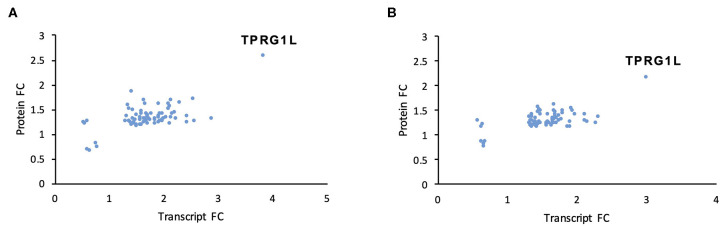
Dysregulation of cellular transcripts and proteins in RNA1.2 mutant-infected cells. HFFF2 cells were infected with WT, ΔRNA1.2 or ΔTATA at MOI = 5 and analyzed at 72 h p.i. For examination of the cellular transcriptome, RNA was extracted from infected cells and polyadenylated transcripts were subjected to transcriptomic analysis. The results of three independent experiments are shown. For examination of the cellular proteome, whole cell lysate was harvested and analyzed in a single mass spectrometry experiment. Cellular genes were identified on the basis of consistent dysregulation in ΔRNA1.2- and ΔTATA-infected cells, as assessed by both transcriptomics and proteomics. (A,B) Differential expression data for all 76 genes dysregulated in both ΔRNA1.2- and ΔTATA-infected cells. FC, fold change.